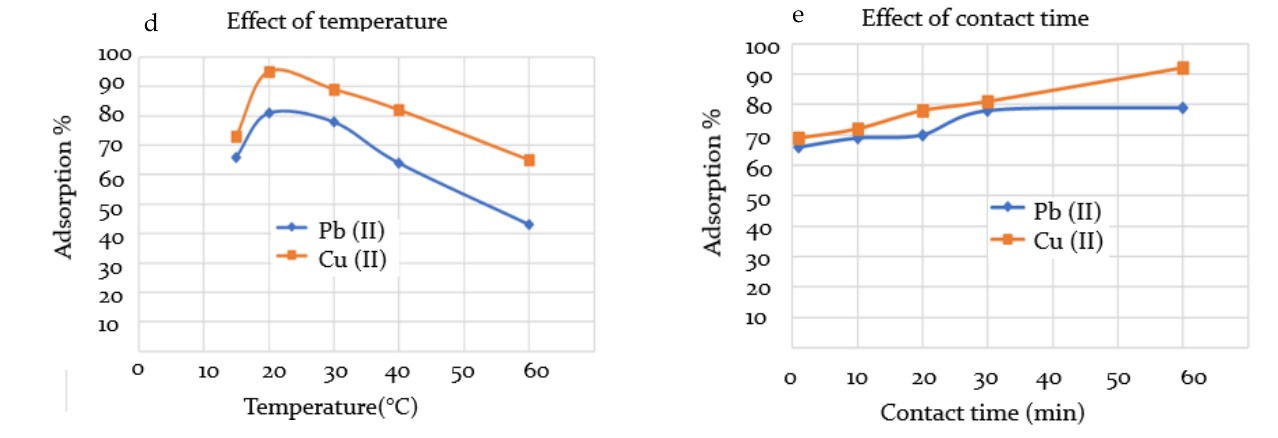
Figure 7. The effect of ( a ) pH on adsorption efficiency (time 30 min, temperature 25 ◦ C, adsorbent dose 50.0 mg, metal ion concentration 30.0 mg, and solution volume 10.0 mL), ( b ) adsorbent dose (CMOISW) (time 30 min, temperature 25 ◦ C. pH 6.0, metal ion concentration 30.0 mg, and solution volume 10.0 mL), ( c ) metal initial concentration (time 30 min, temperature 25 ◦ C, adsorbent dose 50.0 mg, pH 6.0, and solution volume 10.0 mL), ( d ) temperature (time, 30 min, temperature 25 ◦ C, adsorbent dose 50.0 mg, metal ion concentration 30.0 mg, and solution volume 10.0 mL), and ( e ) contact time (temperature 25 ◦ C, adsorbent dose 50.0 mg, metal ion concentration 30.0 mg, and solution volume 10.0